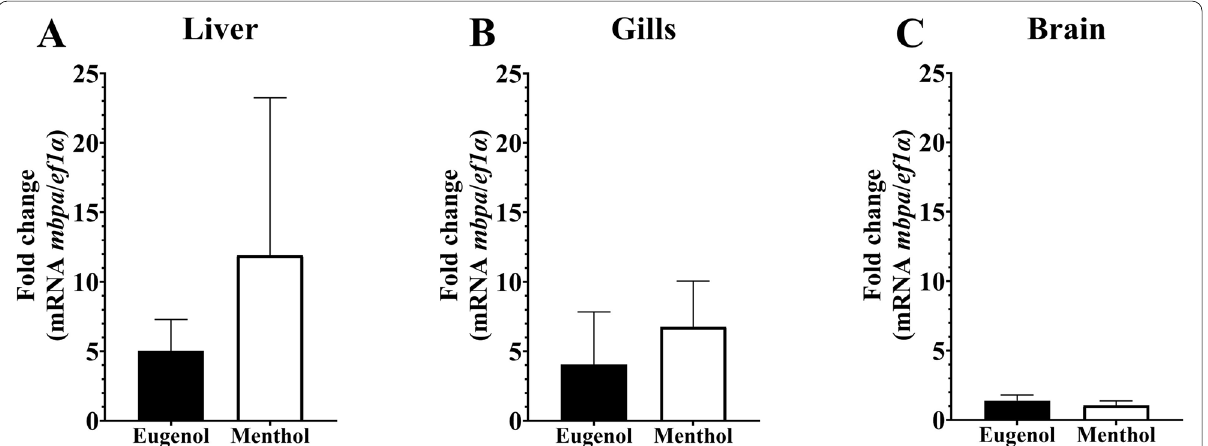
Fig. 5 Relative gene expression of mbpa transcripts in Piaractus brachypomus under anesthesia with eugenol (40 mg/L) and menthol (50 mg/L). A mbpa levels in liver tissue; B mbpa levels in gill tissue; C mbpa levels in brain tissue. ef1a was used as a reference gene. * p < 0.05